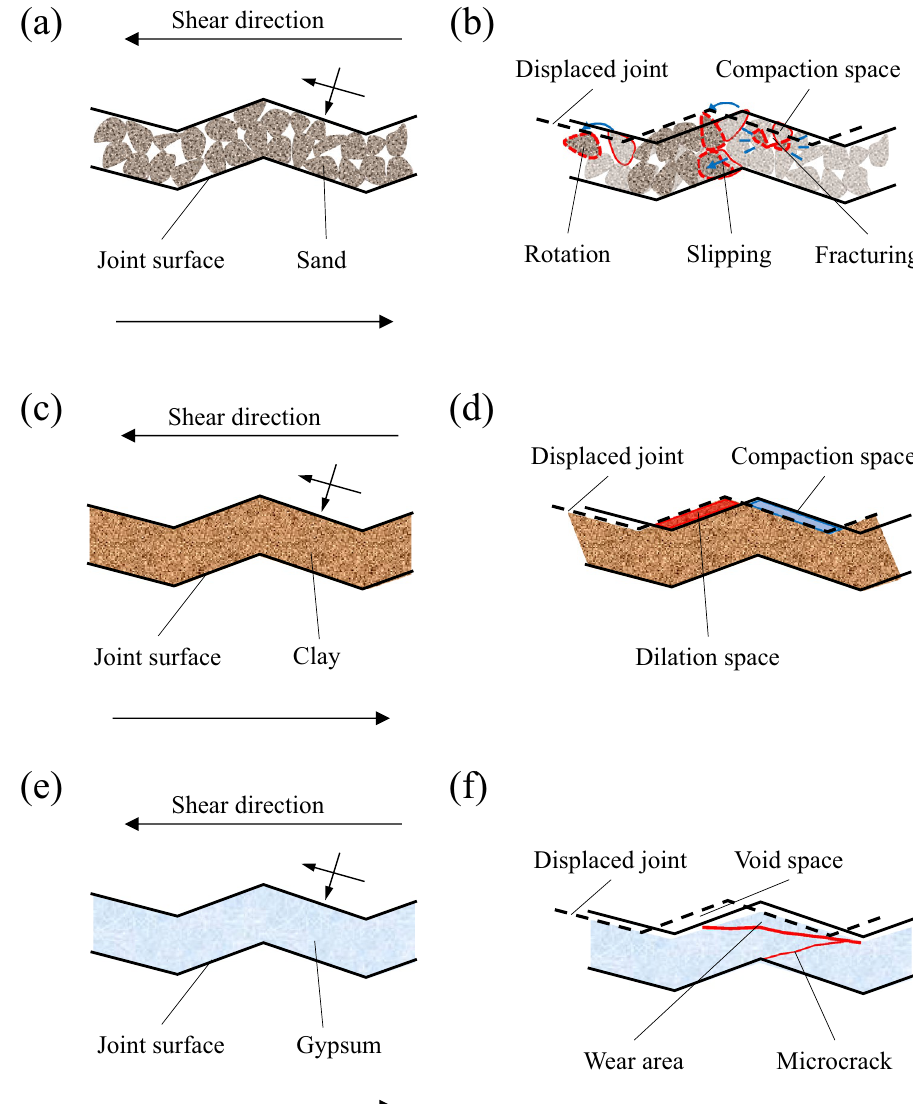
Figure 12. Conceptual scheme of deformation mechanisms of fault gouge, ( a , b ) sand, ( c , d ) clay, ( e , f )